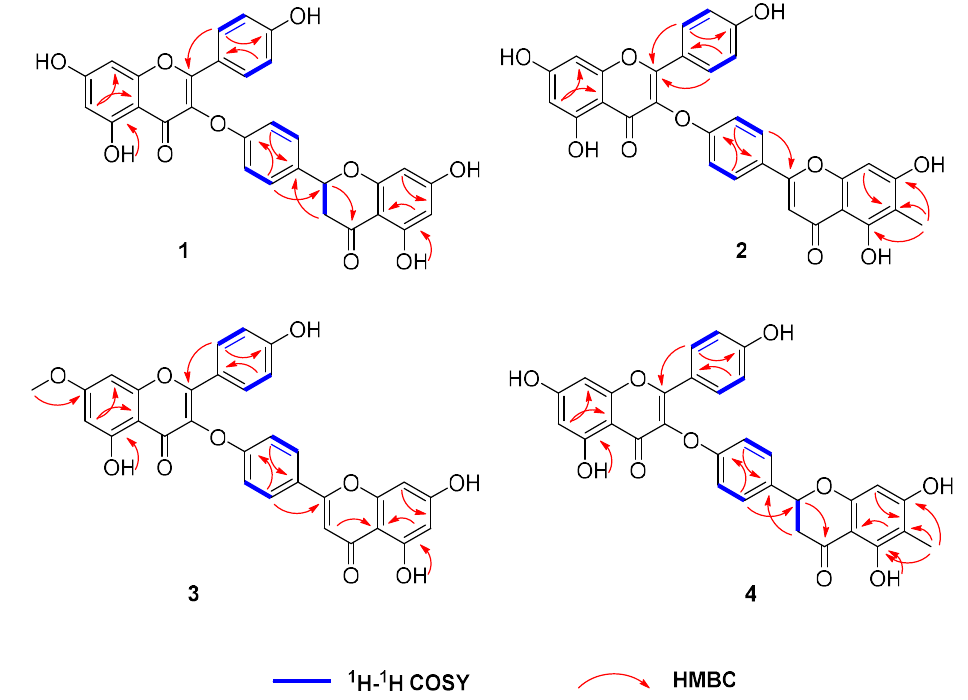
Figure 3. Key 1 H- 1 H COSY and HMBC correlations of compounds 1-4 .